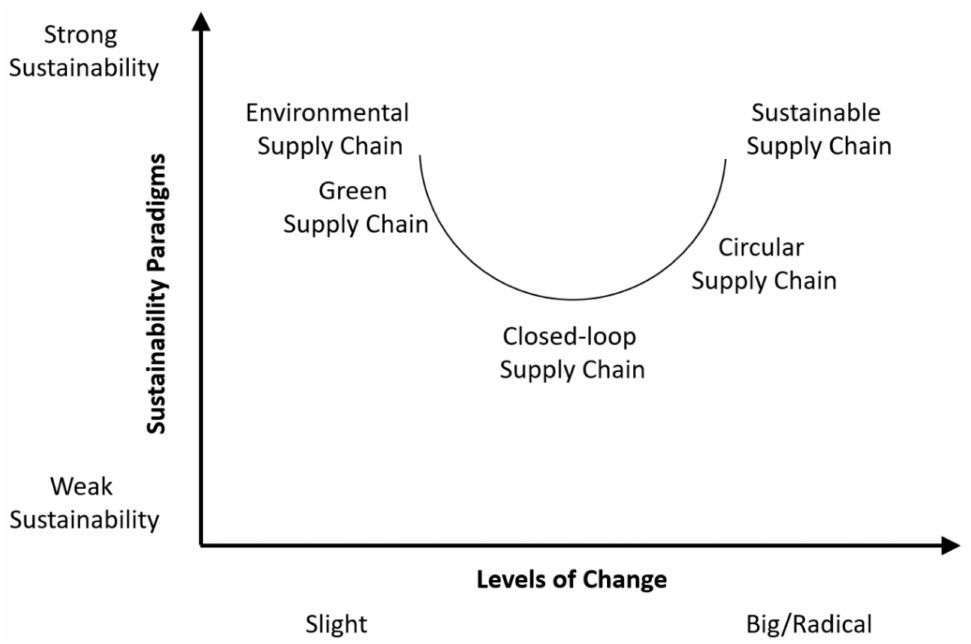
Figure 1. Main features of the SCM types examined (aspects: sustainability paradigms and levels of